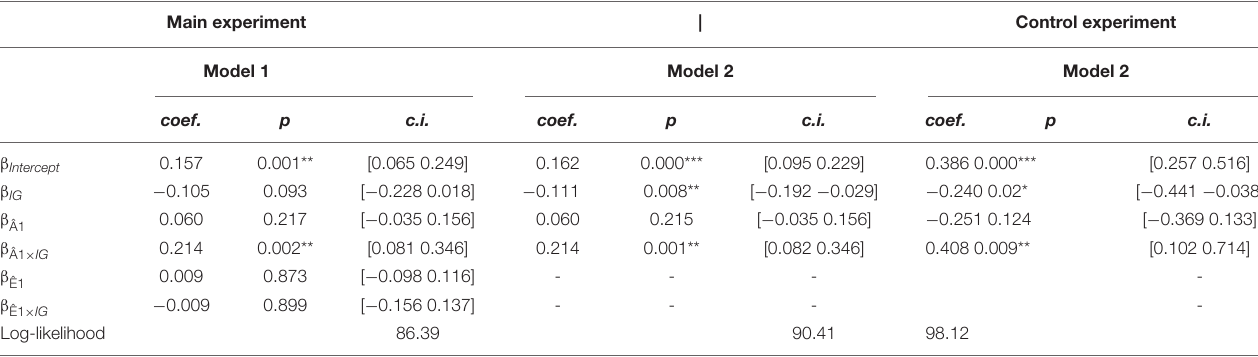
TABLE 1 | Mixed-effect model for the regression of Â 2 on the variables of interest (see Equation 1 and section